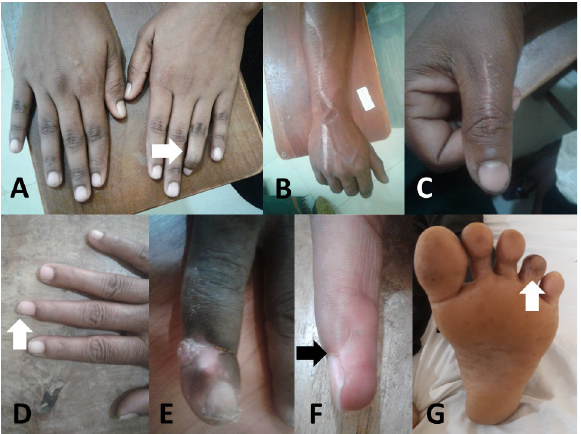
Fig 3. A : Twenty-six-year-old female with contracture formation in palmer aspect of left ring finger following hump nosed viper bite four years previously. B : Twenty-seven-year-old male who developed severe local swelling and compartment syndrome following hump nosed viper bite, one year back, presented with fasciotomy scar extending from the base of the right ring finger up to the elbow. No functional impairment. C : Thirty-three-year-old female with a fasciotomy scar on the right thumb following hump nosed viper bite one year back. D: Forty-nine-year-old female with tissue loss and scarring in the distal phalanx of the right middle finger following Russell’s viper bite one year back. E : Forty-six-year-old female with contracture formation in the distal interphalangeal joint of left index finger following Russell’s viper bite four years back. F : Forty-nine-year-old female with slight tissue loss at the distal phalanx of the right middle finger following Russell’s viper bite one year back. G : Fifty-eight-year-old male with contracture formation of the plantar aspect of left third toe following hump nosed viper bite one year back.